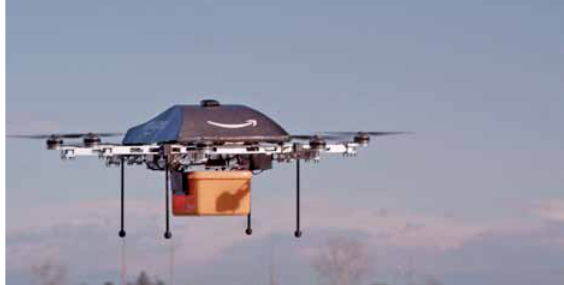
Fig. 3. Amazon prime air